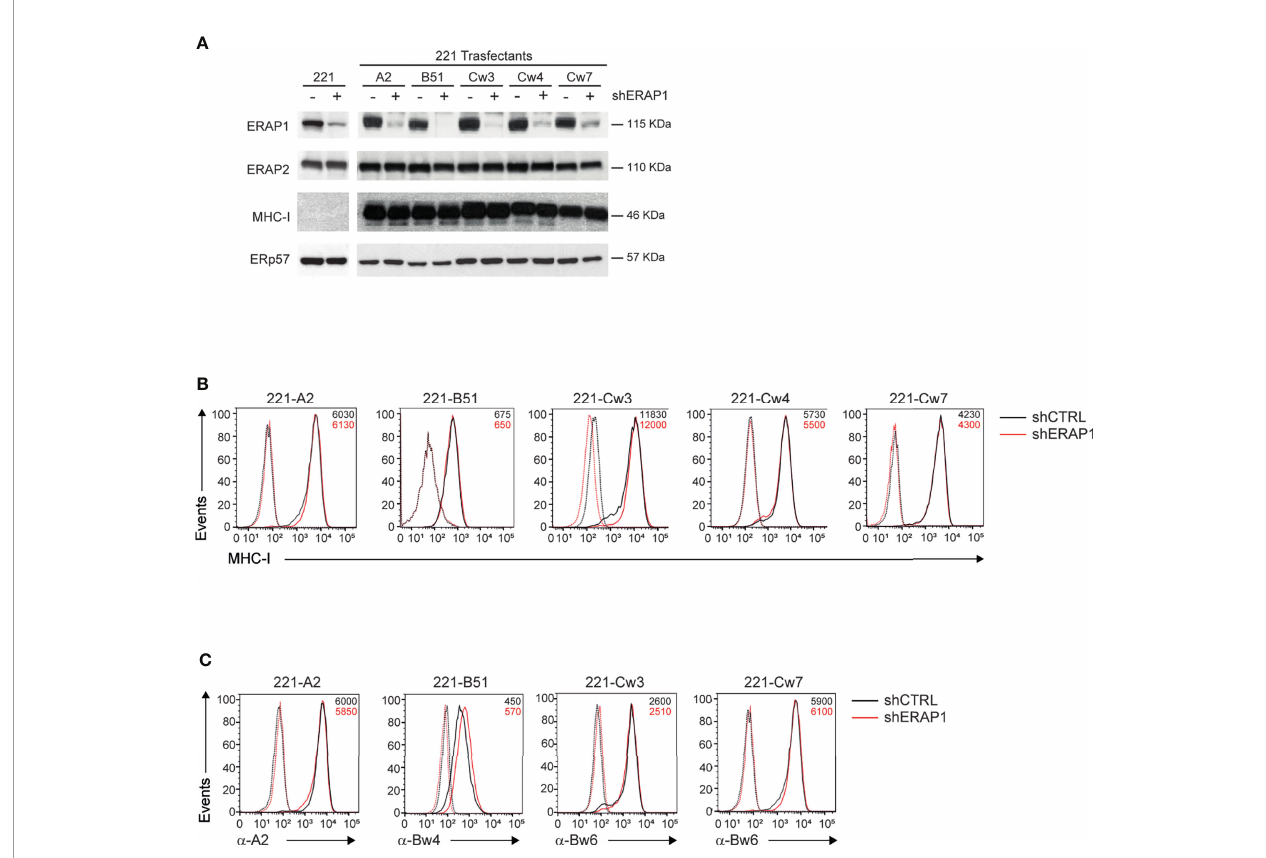
FIGURE 2 | Inhibition of ERAP1 does not affect HLA class I surface expression in 221 transfectant cells. (A) , Representative immunoblotting analysis of ERAP1, ERAP2 and HLA class I expression in the indicated 221 parental and transfectant cells transduced with lentiviral vectors encoding either control shRNA (-) or ERAP1 shRNA (+). An ERp57 antibody was used for normalization. (B, C) , Representative fl ow cytometric analyses of HLA class I expression in the indicated cells with the pan-anti HLA class I W6/32 antibody (B) and anti-HLA-A2 (BB7.2), anti-HLA-Bw4, and anti-HLA-Bw6 antibodies (C) . Isotype-matched negative control antibodies are as dotted lines. MFI value for speci fi c antibody staining are